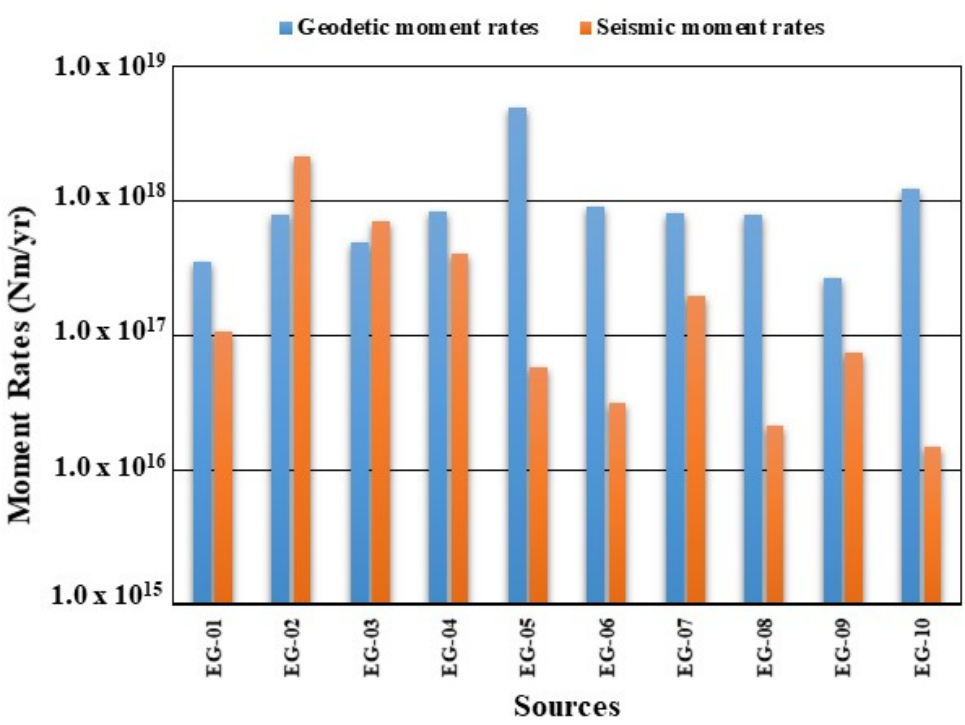
Figure 7. Comparison between the estimated values of the geodetic and seismic moment-rates.